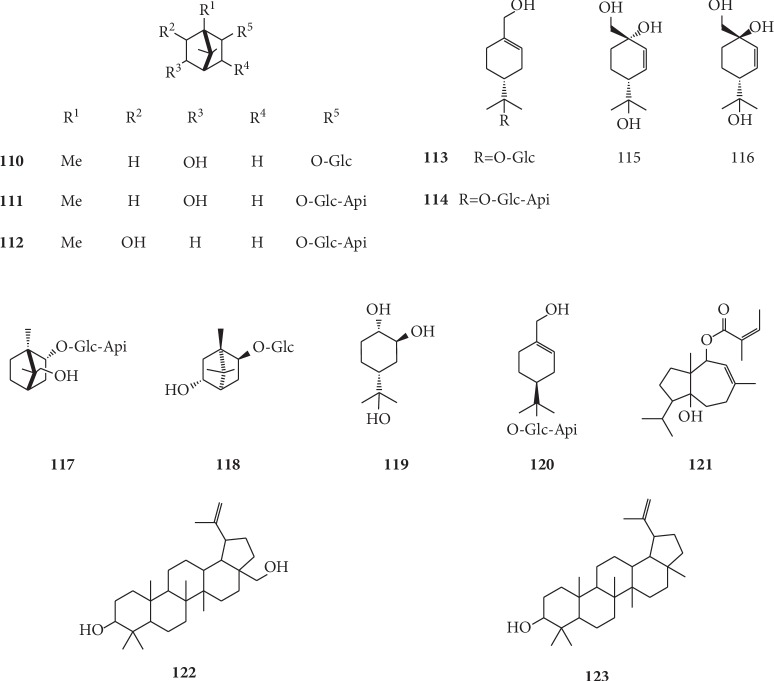
Structures of terpenoids in G. littoralis.